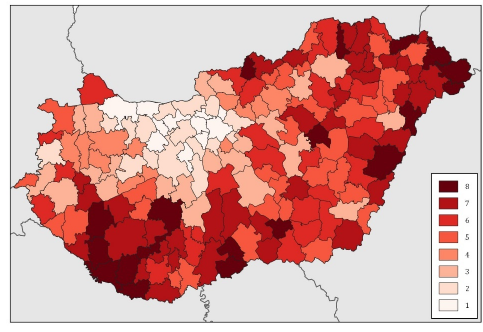
Figure 11: Clustering of the micro-regions based on the death rate within COVID-19 infected people and various socio-economic